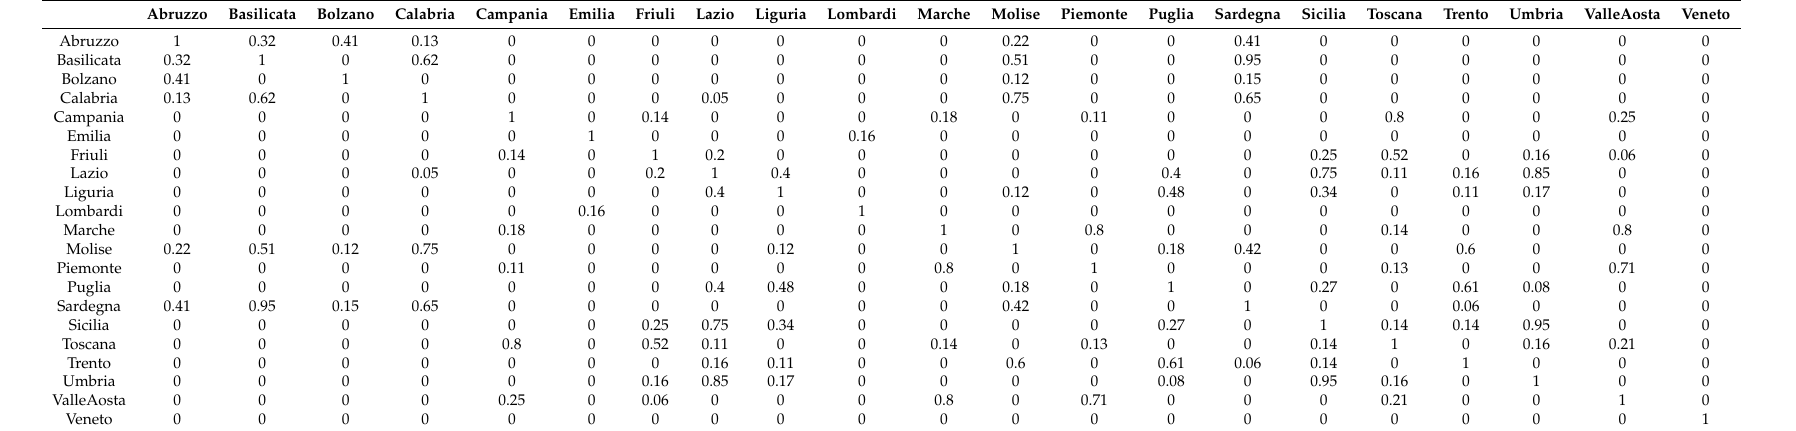
Table A21. Similarity values of Home Isolation network in the second week.